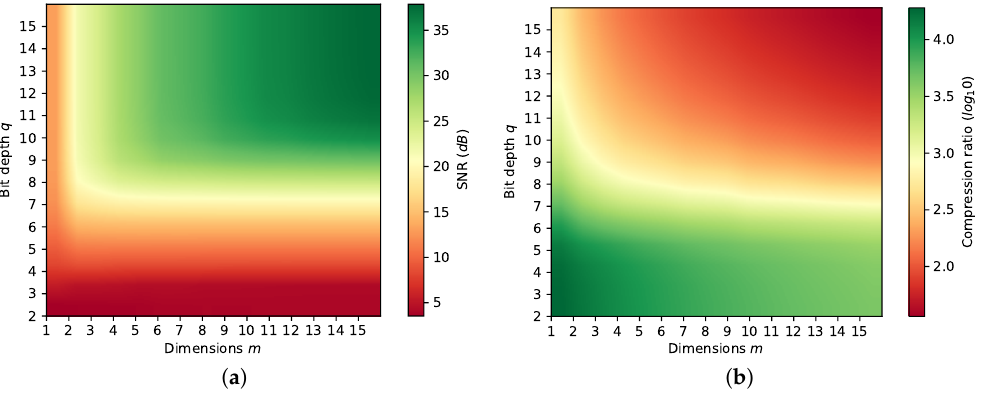
Figure 2. Signal Noise Ratio (SNR) and compression ratio results for the Cuprite image. ( a ) SNR as a function of the dimensions m and bit depth q . Note how, for shallow bit depths, m has little effect in SNR; ( b ) Compression ratio as a function of the dimensions m and bit depth q . An increase of any of them implies a reduction in ratio.